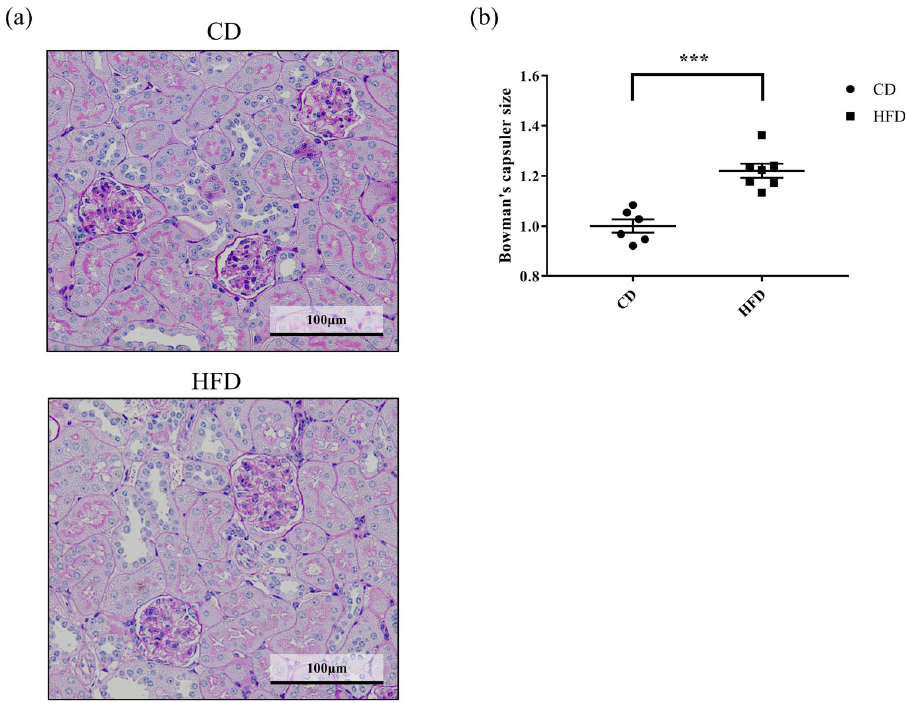
Fig 1. Effect of HFD on glomerular size. (a) Representative images of periodic acid–Schiff-stained C57BL6/J mouse renal tissue sections. (b) Quantification of the size of glomeruli. Results are expressed relative to Bowman’s capsule area. At least 20 glomeruli from the all mice are quantified. Bars indicate mean ± SEM. ��� p < 0.001 (unpaired t-test). n = 6 in CD and 7 in HFD, respectively. CD, control diet group; HFD, high-fat diet group.